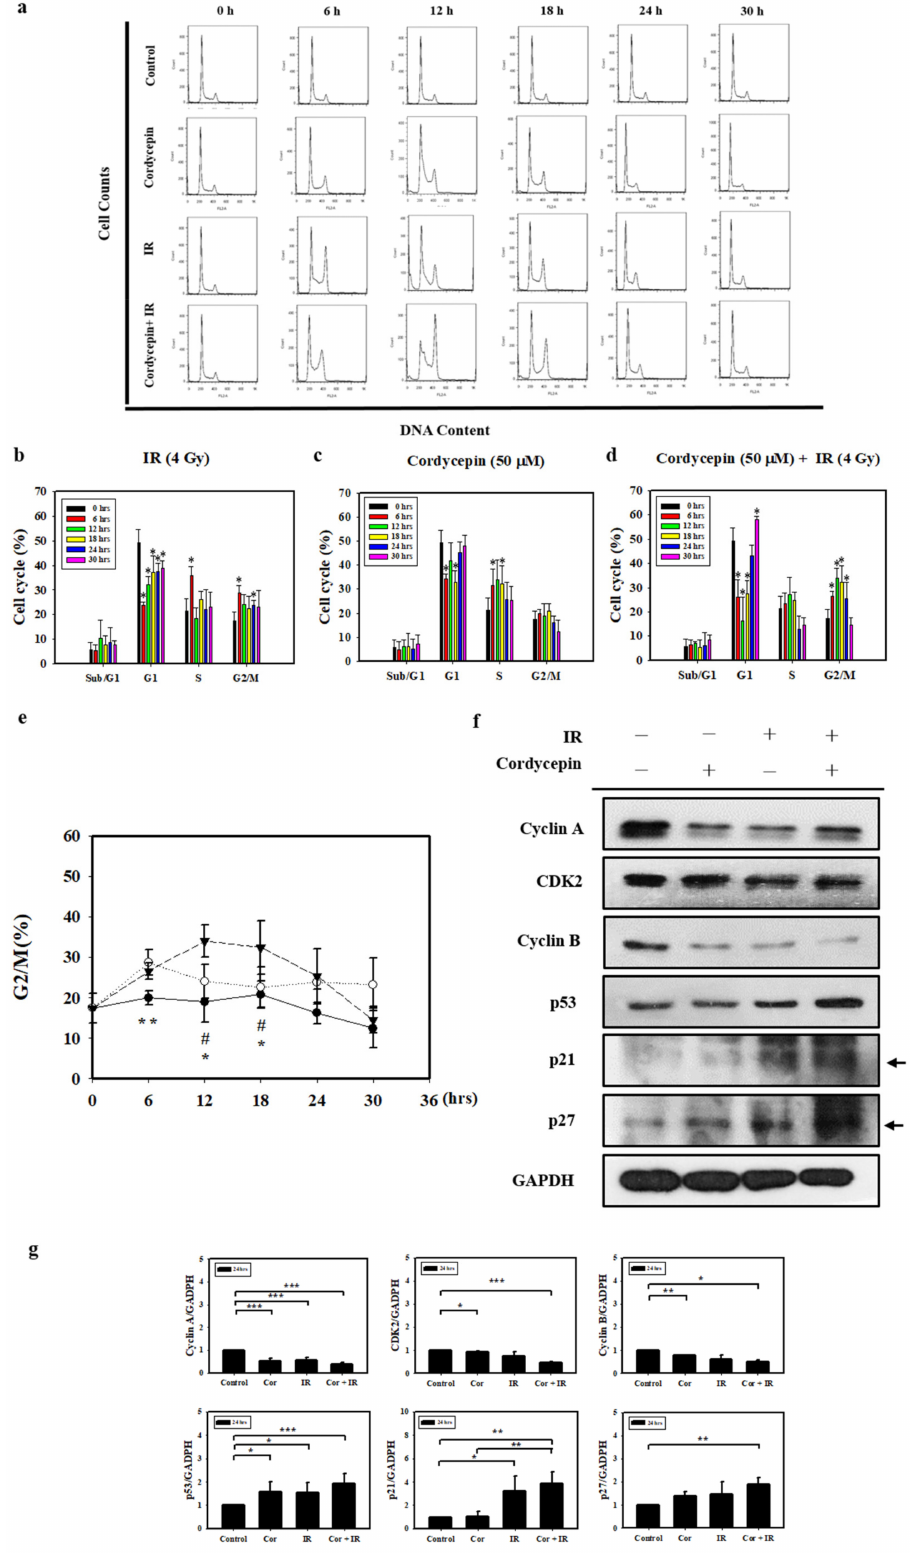
Figure 4. Cell cycle distribution of SAS cells treated with cordycepin and / or IR. ( a ) Time-dependent e ff ects of cordycepin and / or IR on cell cycle distribution in SAS cells. Cells were treated with 50 µ M cordycepin and / or 4 Gy IR for 6, 12, 18, 24, and 30 h. ( b ) The e ff ects of IR on the cell cycle in SAS cells. Cells were treated with 50 µ M cordycepin for 6, 12, 18, 24, and 30 h. * p < 0.05, treated groups versus 0